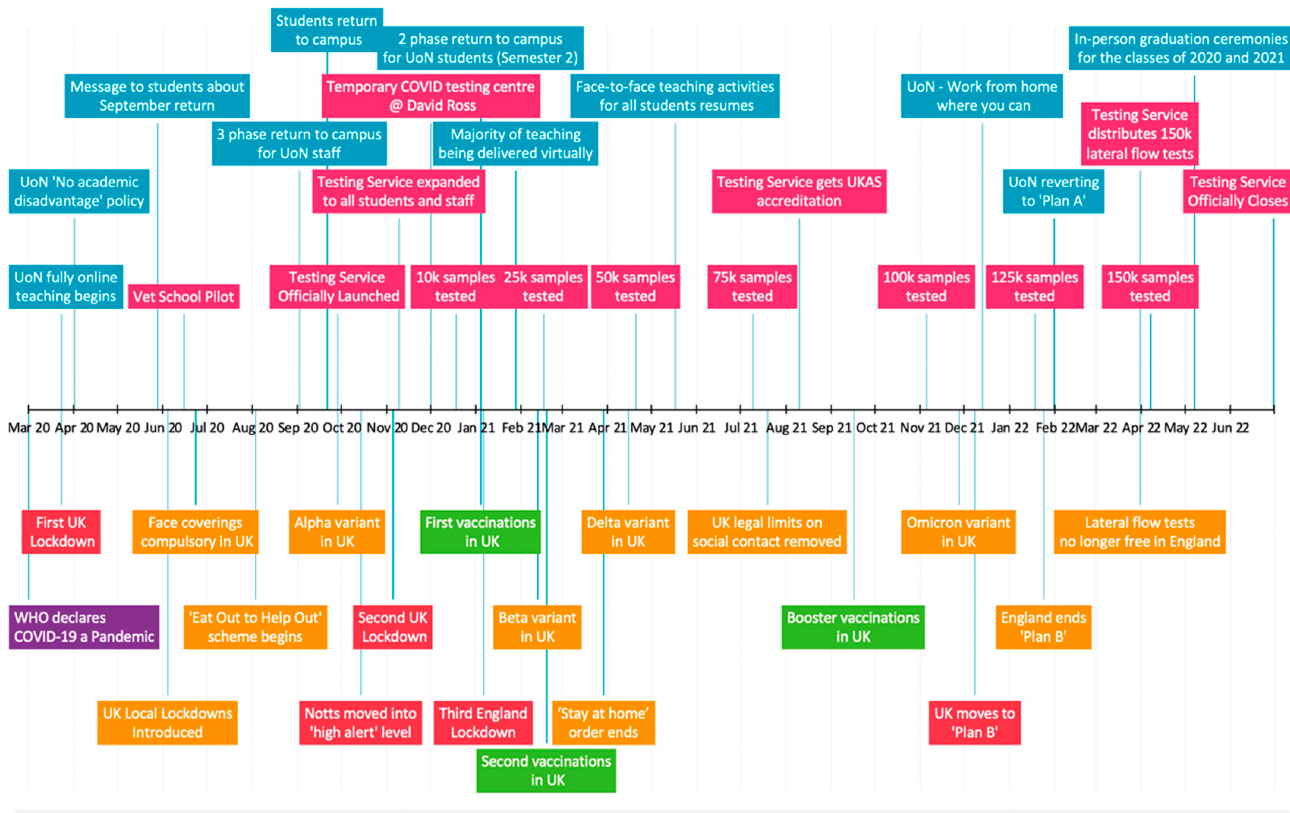
Figure 1. Asymptomatic testing service and COVID-19 timeline. UK: United Kingdom; WHO: World Health Organization; UoN: University of Nottingham; Notts: Nottingham; Vet School Pilot [19]; David Ross: University sports facility and temporary testing site venue; Plans A and B (see www.gov.uk (accessed on 8 October